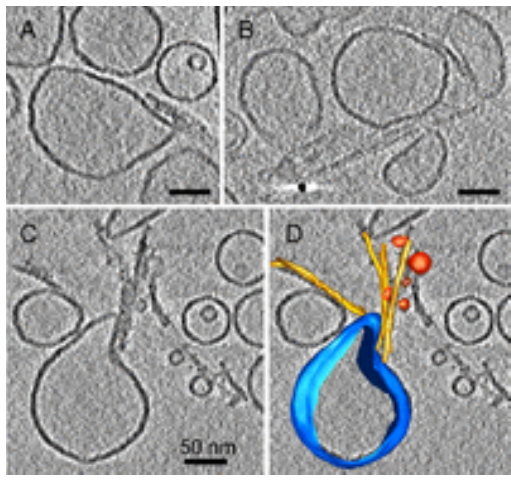
Figure 7. Distortion of liposomes caused by fibril of β2-microglobulin visualized by cryoelectron tomography ( A – C ) sections of tomogram; ( D ) rendered 3D model of (C). (C,D) also show blebbing. Modified from Milanesi, L. et al ., Proc. Natl. Acad. Sci. USA 2012 , 109 , 20455–20460. Copyright Milanesi, L. et al . 2012